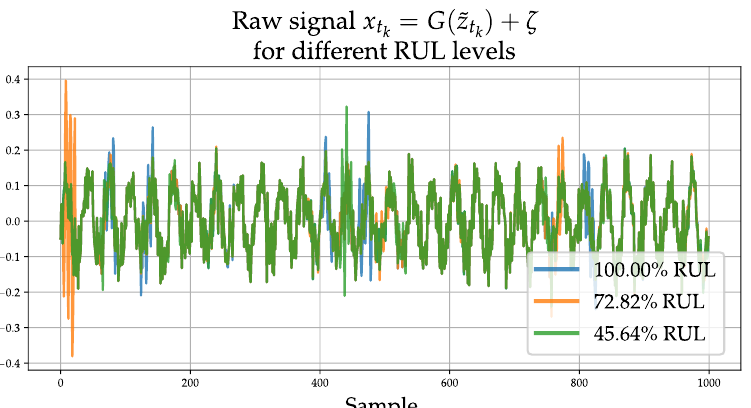
. The blue points are z t k